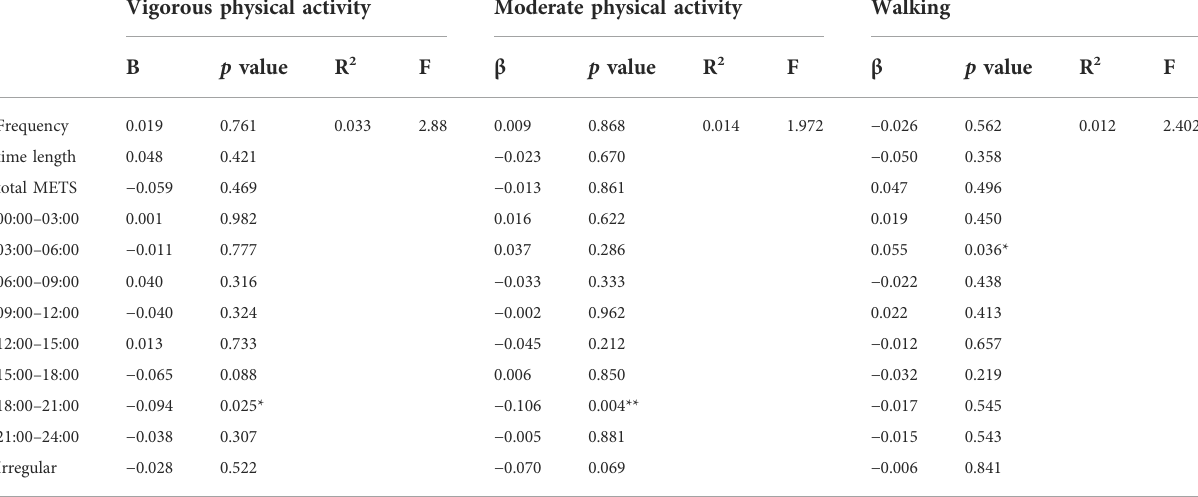
TABLE 3 Association between physical activity and diastolic blood pressure. Vigorous physical activity Moderate physical